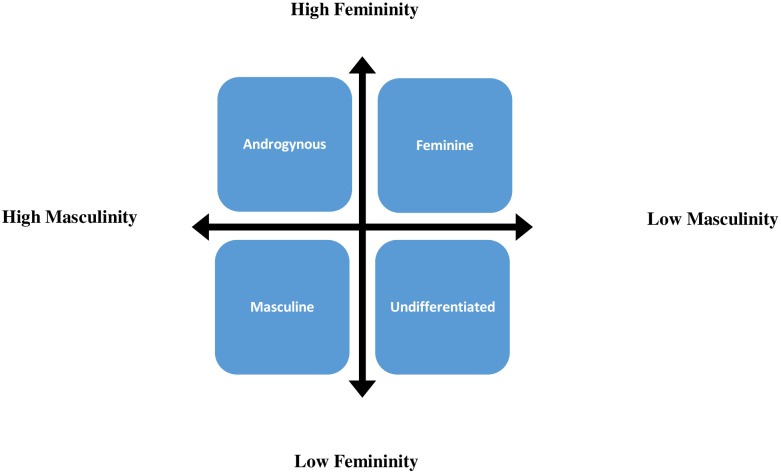
The Androgyny Model.